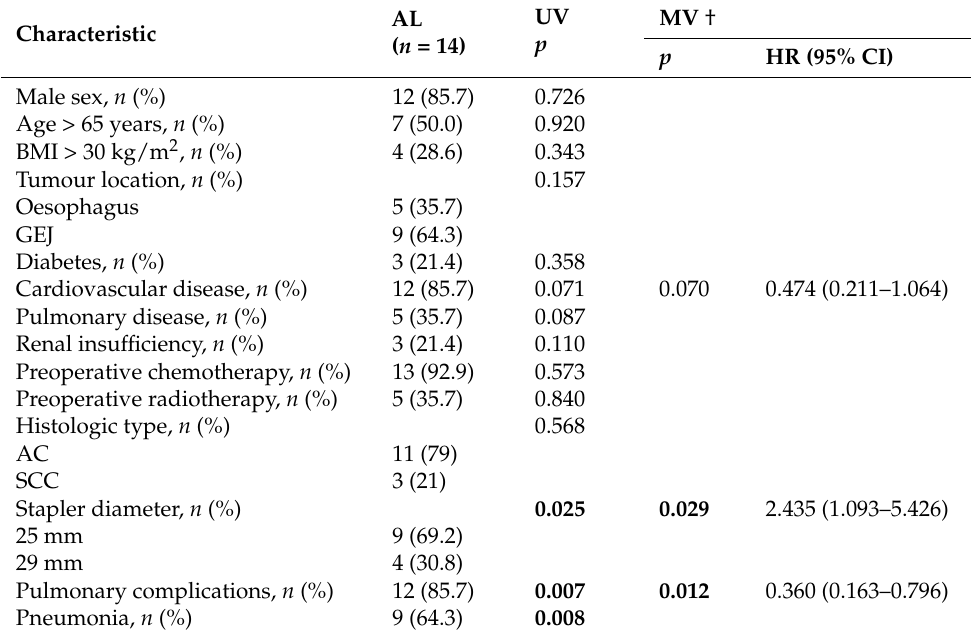
Table 3. Risk factors for perioperative anastomotic